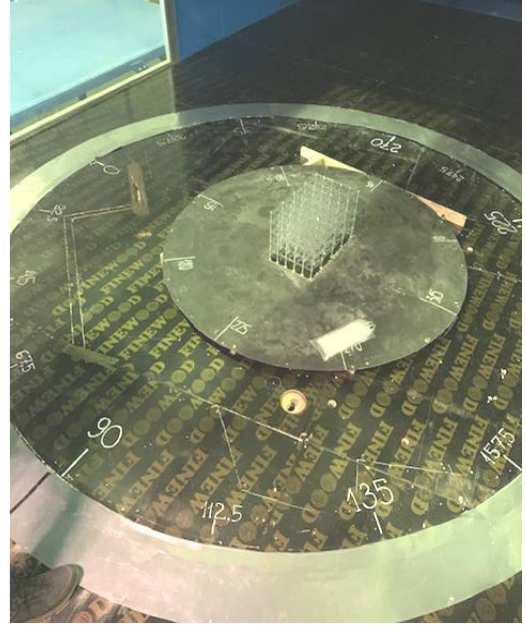
Figure 6. Scheme of the turntable with a mounted aeroelastic model.